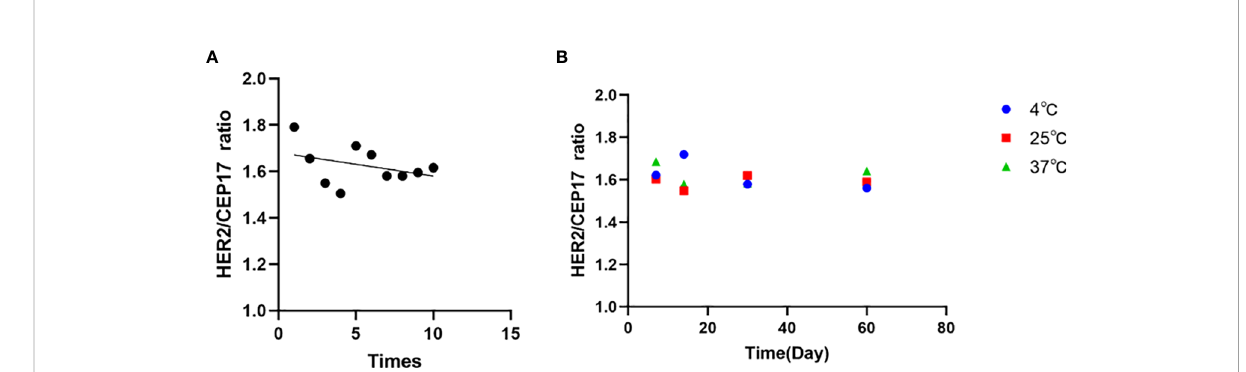
FIGURE 6 Sample validation and homogeneity and stability assessment of the FFPE reference materials by ddPCR. (A) Sample validation by ddPCR of the FFPE reference materials. Data shown in the form of ratio (HER2/CEP17). (B) Homogeneity and stability assessment of the FFPE reference materials showing that no signi fi cant trends in the ratio are detectable within the detection limits of the assays. The mean values of all samples are consistent with their individual target